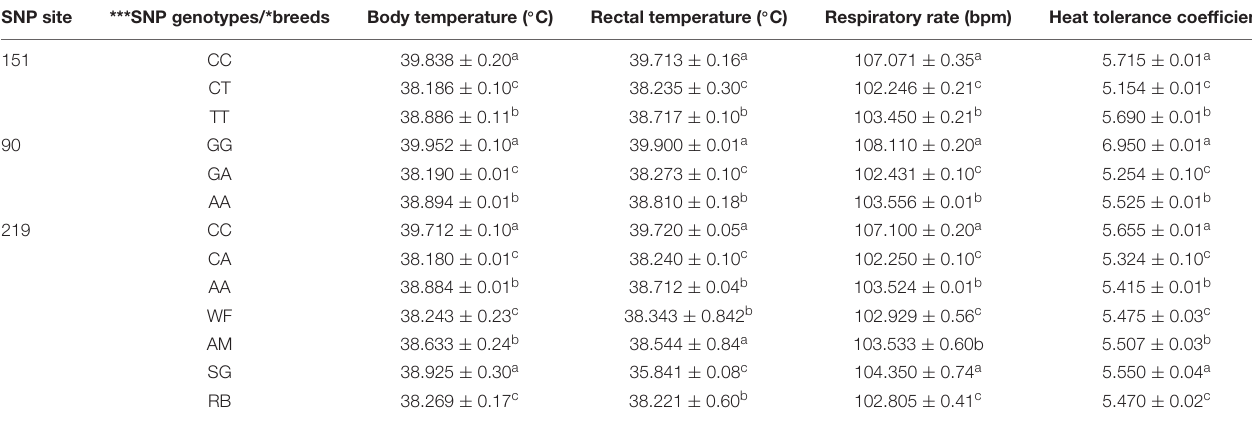
TABLE 7 | Mean ( ± SE) values of heat related parameters in the study animals in relation to three SNP sites of HSP 70. SNP